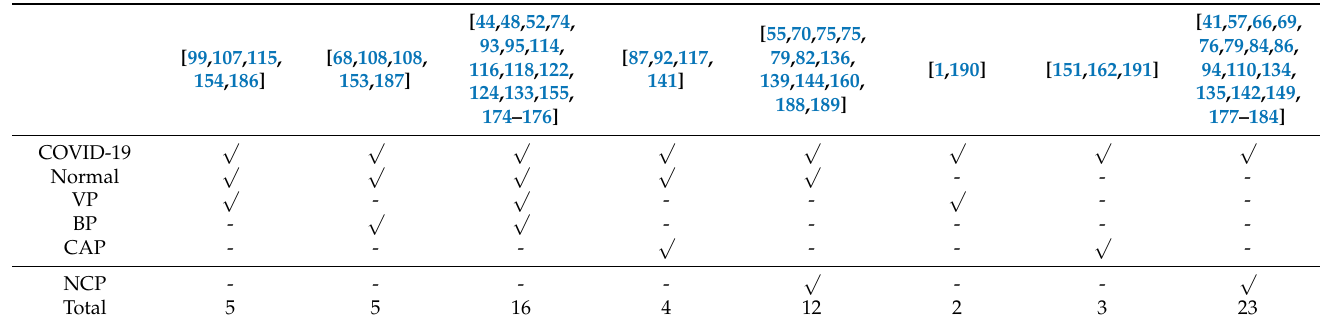
Table 5. Classes involved in multi-class classification models. VP: viral pneumonia; BP: bacterial pneumonia; CAP: community-acquired pneumonia; NCP: non-COVID-19